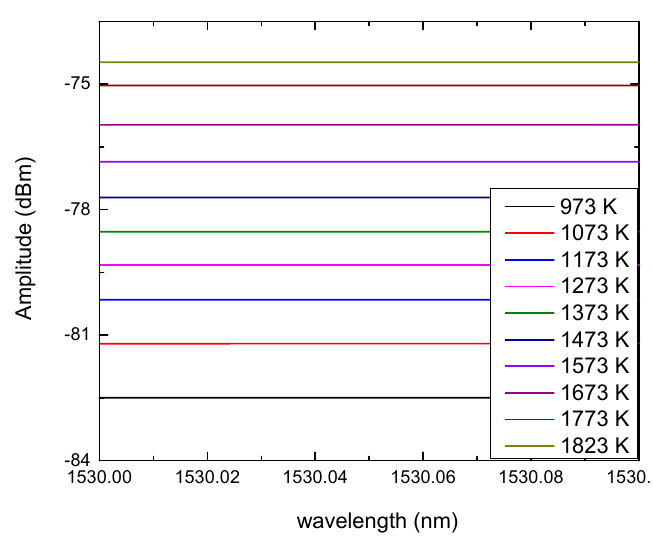
Figure 3. The output light intensity of the sensor collected by the spectrometer at different temperatures. The temperature responses of the optical fiber infrared radiation sensor in the three heating processes are shown in Figure 4. The temperature response sensitivities of the same optical fiber sensor are 0.010 dBm/K, 0.010 dBm/K, 0.009 dBm/K, 0.010 dBm/K and 0.010 dBm/K, respectively. It can be obtained that the sensor has good repeatability.